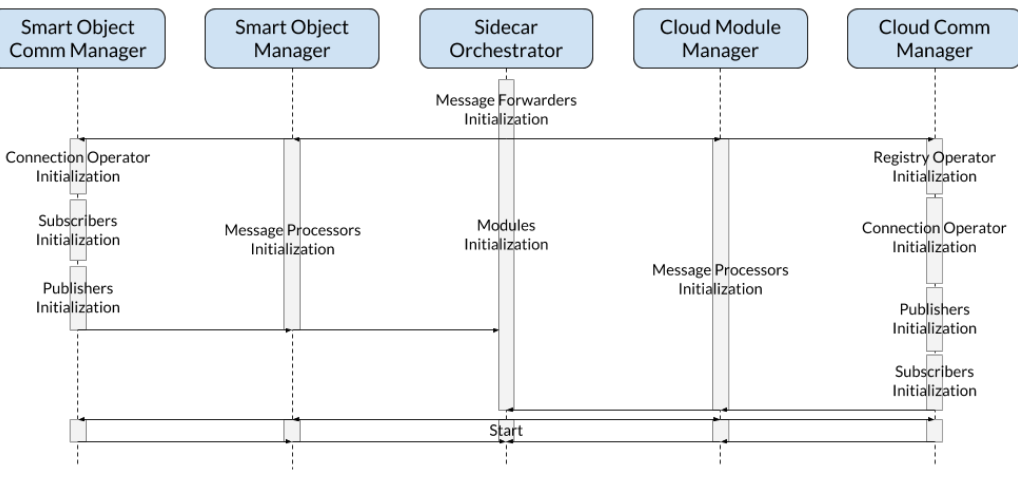
Figure 3. Startup sequence